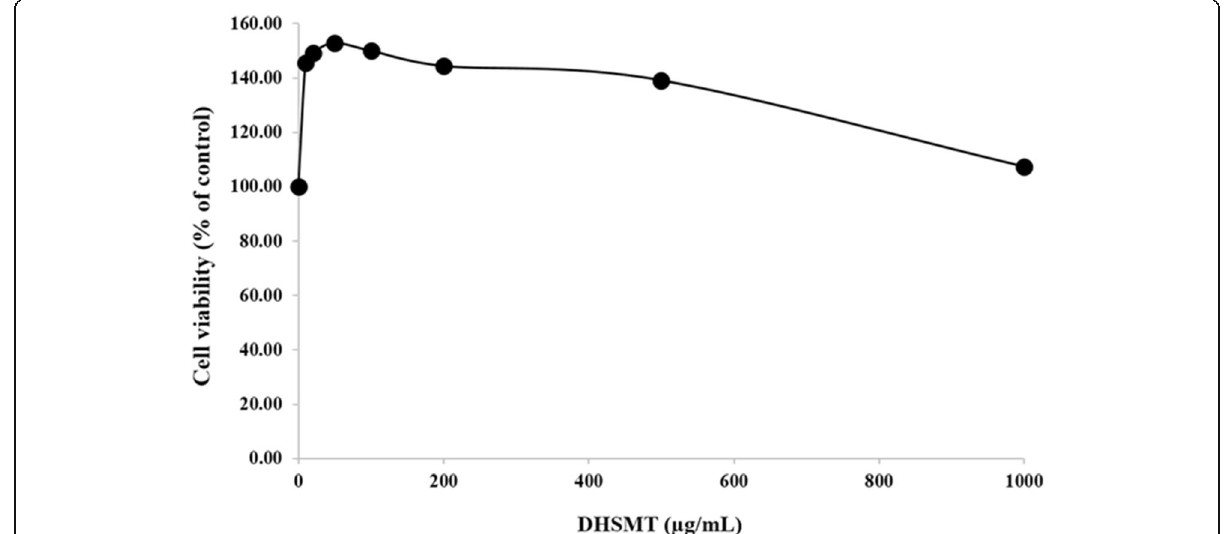
Fig. 1 Cytotoxic effects of DHSMT in 3T3-L1 cells. 3T3-L1 cells were treated with various concentrations of DHSMT (0, 10, 20, 50, 100, 200, 500 and 1000 μ g/mL) for 48 h. Cell cytotoxicity was measured by using CCK-8 kit and the absorbance was measured at 450 nm. The data are mean values